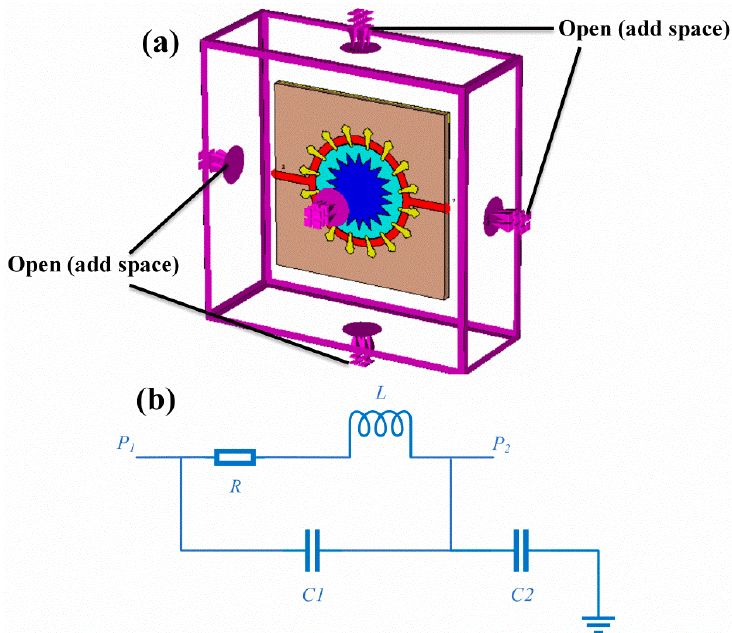
Figure 2. Metamaterial-based sensor with a corona-shaped resonator: ( a ) the boundary conditions and ( b ) equivalent circuit diagram whereas L denotes the inductance of the corona-shaped resonator, R is the resistance, and the capacitance between the outer ring and conductor is C 1 , while C 2 is the capacitance between the inner conductor and copper ground plate.